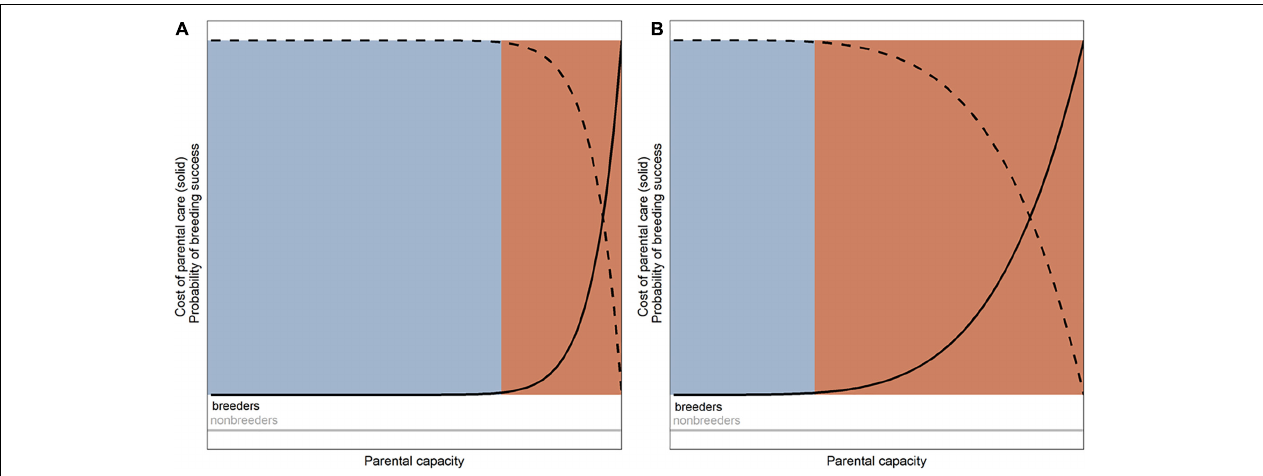
FIGURE 2 | The cost of parental care of an individual (in terms of the parental survival and its future fecundity; solid line) and the related to that probability of the success in the current reproductive attempt (dashed lines) with regard to the concept of parental capacity. Blue and red areas denote optimal and suboptimal range of parental capacity, respectively. (A) Species of wide parental capacity, adapted to highly variable environments. (B) Species of narrow parental capacity, adapted to harsh and/or predictable